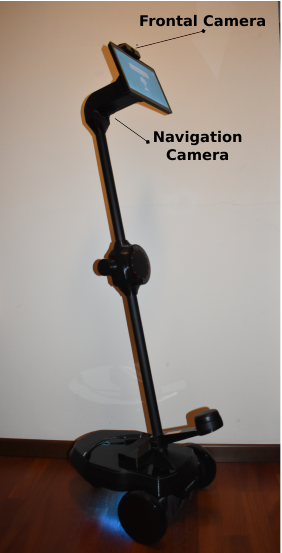
Figure 4. Our robotic